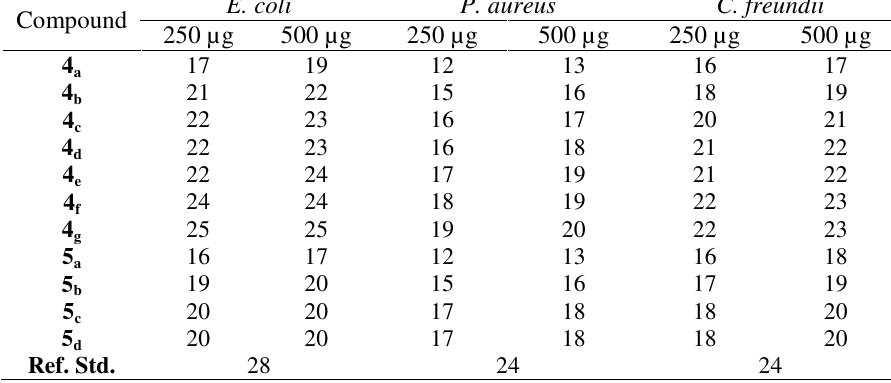
) and (5 ) (Zone inhibition in mm) a–g a–d